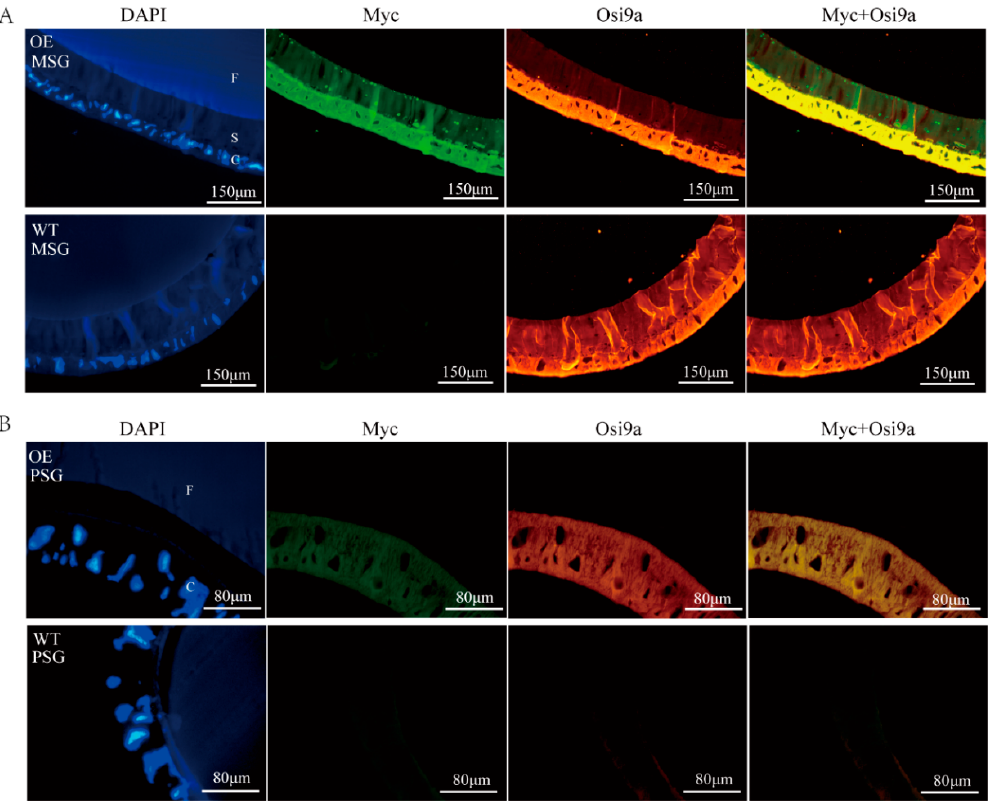
Figure 2. Location of transgenic overexpressed BmOsiris9a in the silk gland. ( A ). Immunofluorescence of BmOsi9a and Myc in the MSG. ( B ). Immunofluorescence of BmOsi9a and Myc in the PSG. Sections were prepared from the MSG and the PSG of the OE and the WT and were observed under ultraviolet light for DAPI, blue light for FITC, and green light for CY3. C : Cells; S: Sericin layer; F: Fibroin